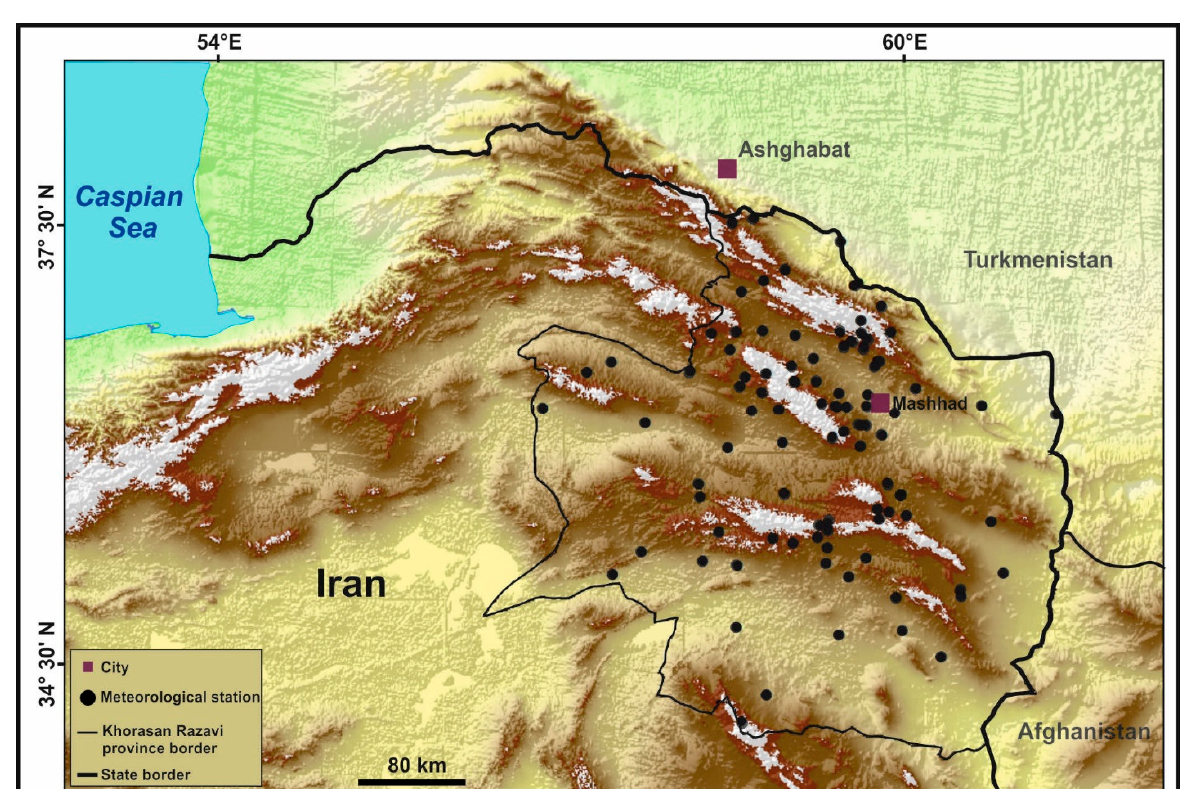
Figure 1. Location of the Khorasan Razavi province in Iran, and distribution of the meteorological stations used for this study (Map sources: Digital Elevation Model GTOPO30: https://earthexplorer.usgs.gov (accessed on 28 April 2021) and Digital Elevation Model ALOS PALSAR: https://vertex.daac.asf.alaska.edu (accessed on 28 April 2021)). Table 1. Locations and altitudes of the meteorological stations used for this study.